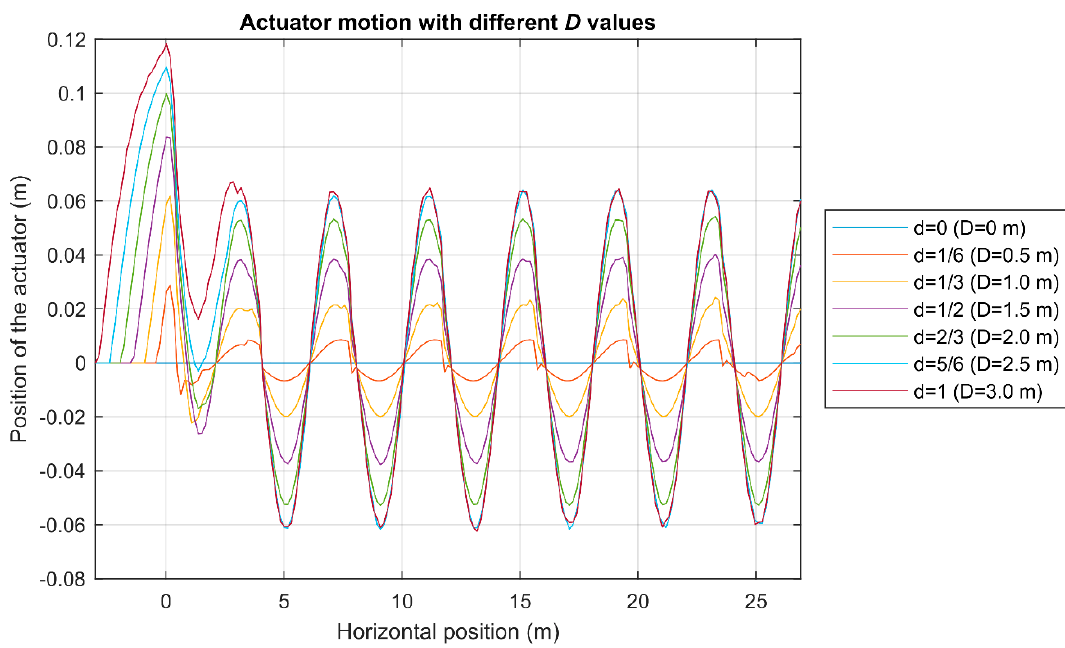
Figure 10. The motion of the actuator in the first ground profile.